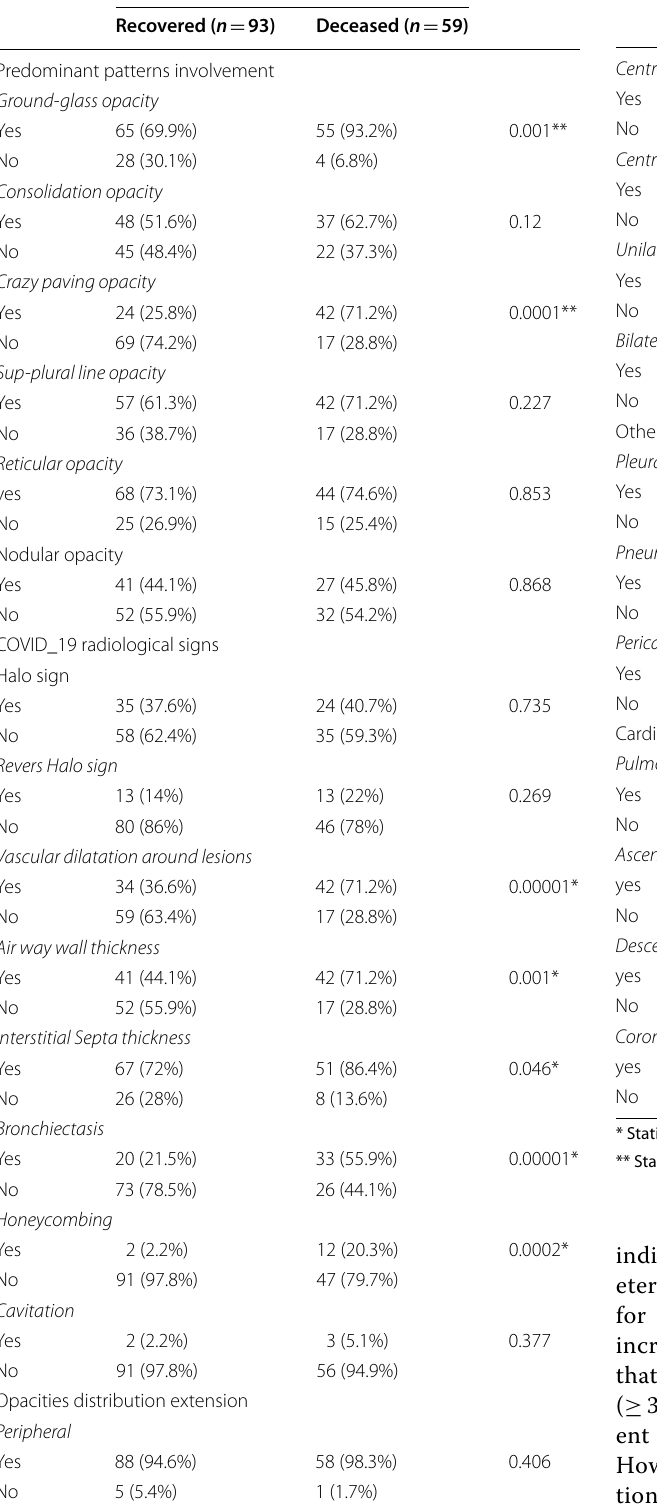
Table 2 Radiological findings of lung CT of COVID‑19 patients